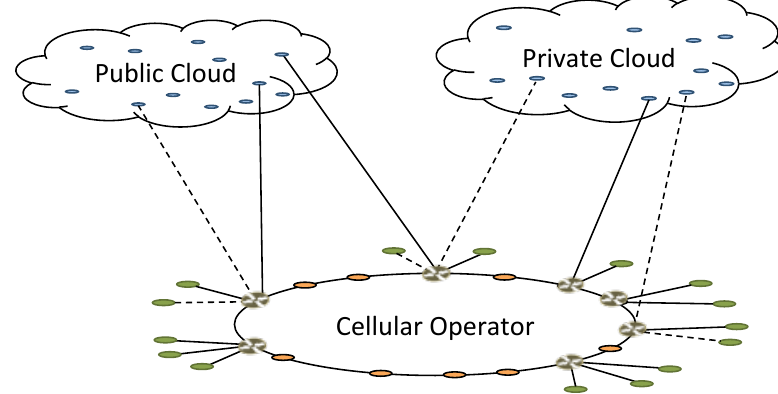
Figure 19. New hosting